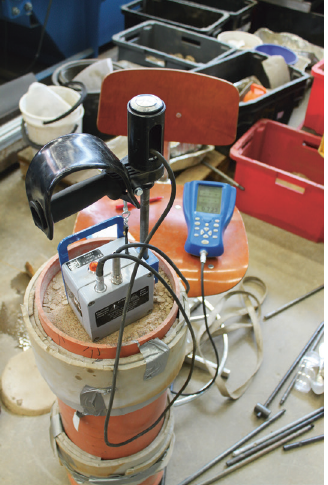
Figure 5. Panda2 test in progress in the